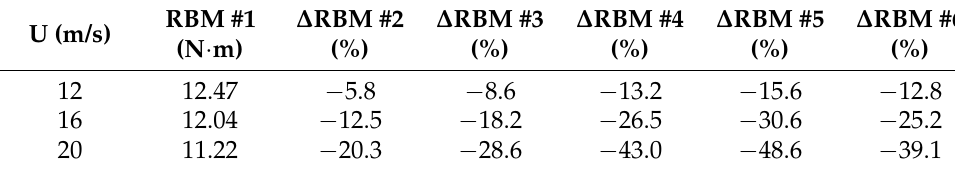
Table 2. RBM differences to configuration #1 at different speeds.